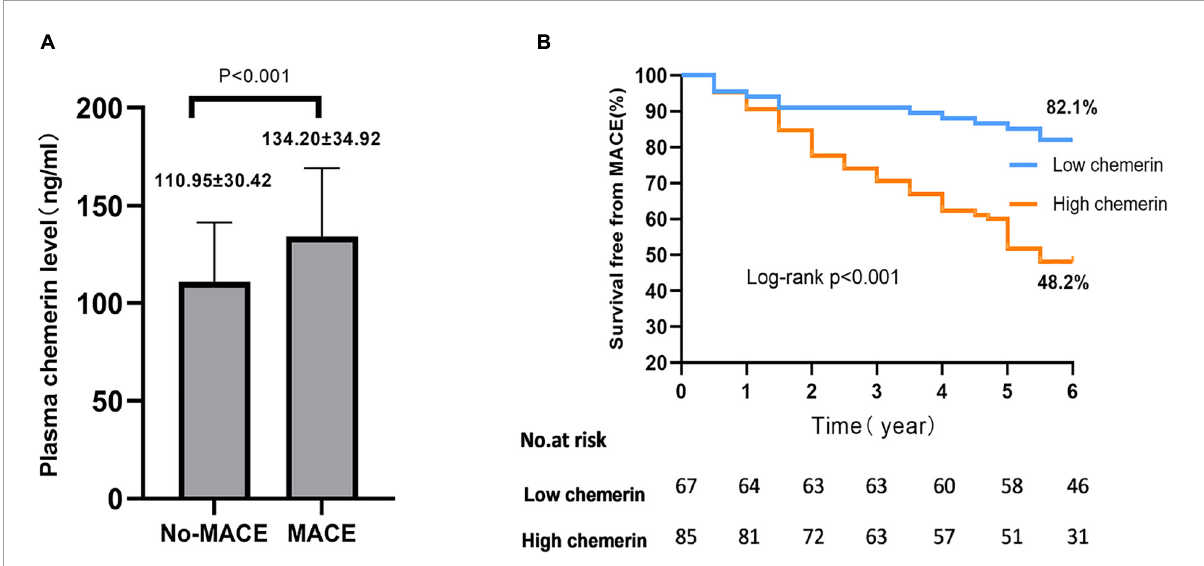
FIGURE2 Plasma chemerin concentrations and MACEs-free of high/low chemerin groups in all patients. (A) Plasma chemerin concentrations were higher in the MACE group compared to the non-MACEs group. (B) Kaplan-Meier curves for freedom from MACEs stratified by chemerin group. MACE, major adverse cardiovascular